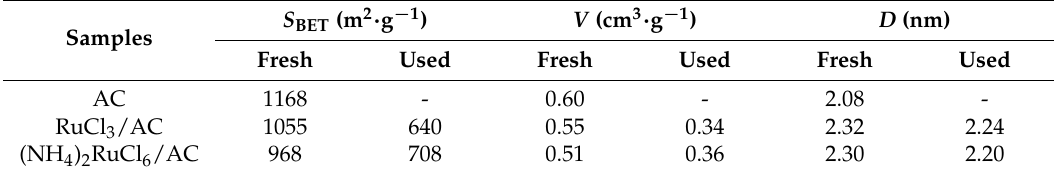
Table 1. Texture parameter of catalysts with Ru loading of 1.0 wt % 1 .